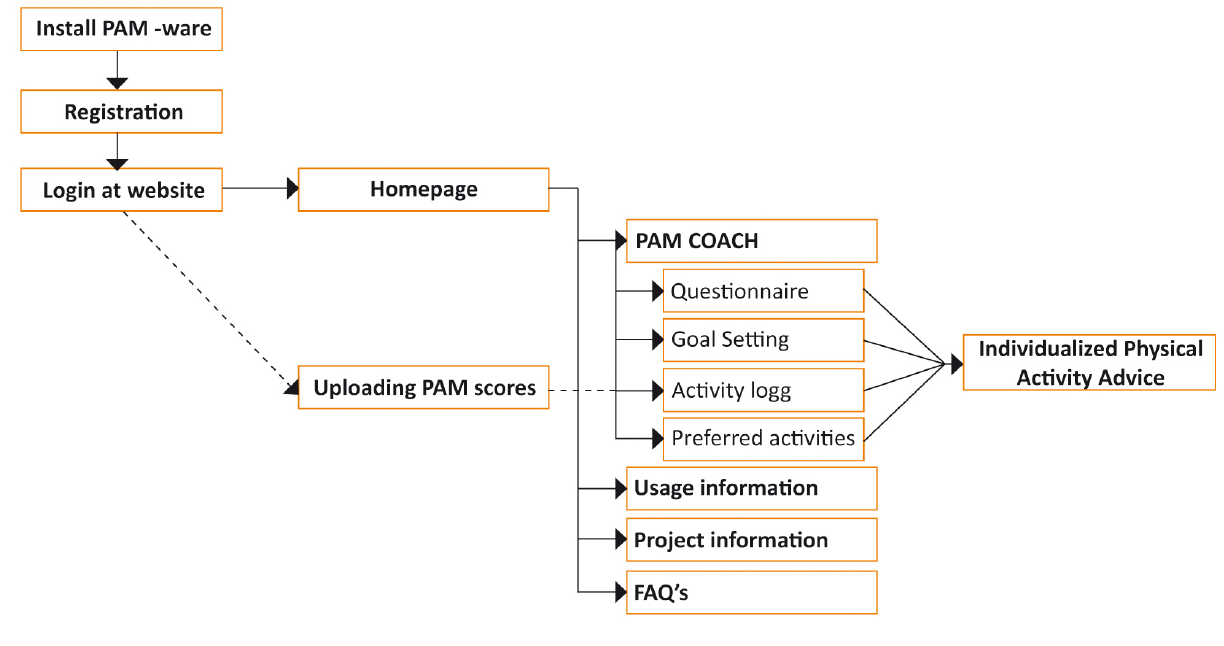
Figure 2. Functionalities of the PAM COACH website